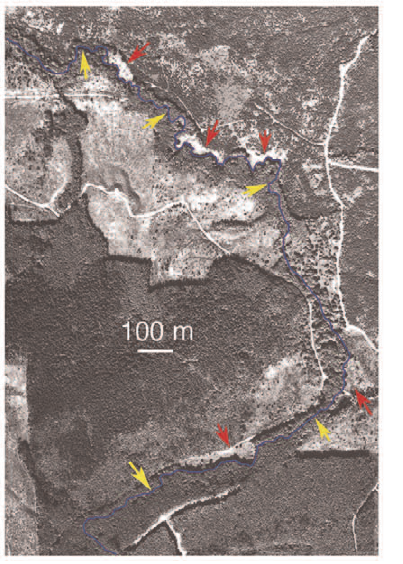
Figure 1. Aerial photograph of riparian manipulations along the South Fork Pysht River, Olympic Peninsula, Washington State, USA. Red arrows indicate manipulated reaches, yellow arrows indicate intervening unmanipulated (control) reaches sampled.